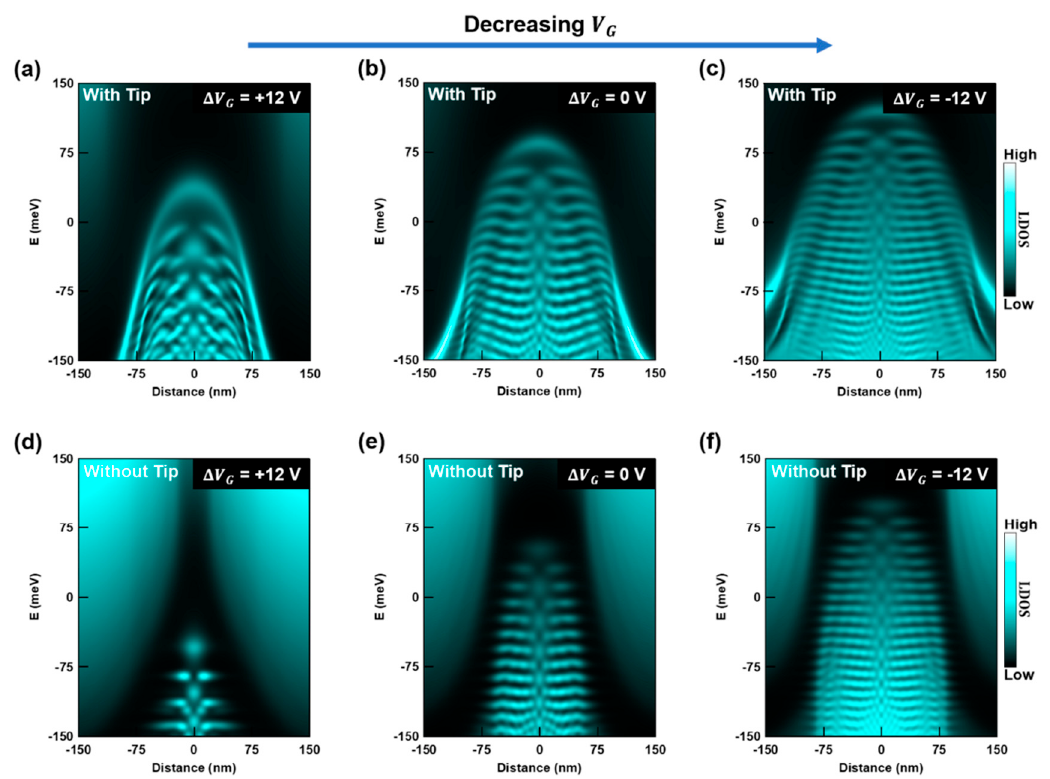
Figure 6. Simulation of the LDOS in a graphene QD with a moving STM tip for di ff erent V G configurations. ( a – c ) Simulated LDOS spectra along a line that crosses the center of a graphene QD.